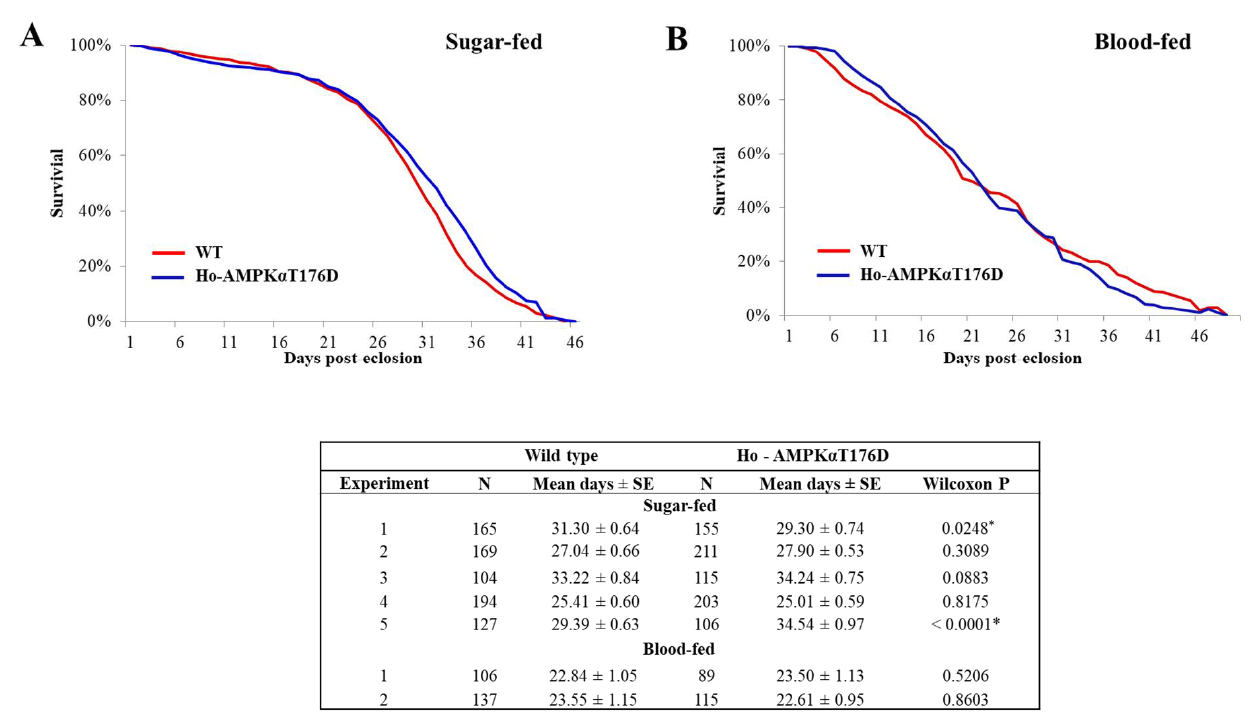
Figure 5. Survivorship of sugar-fed and blood-fed AMPK α T176D homozygous transgenic (TG) and wild type An. stephensi . ( A ) A representative survivorship curve comparing homozygous AMPK α T176D TG and wild type siblings reared under identical conditions and provided with 10% sucrose ad libitum . Lifespan experiments were replicated five times with independent cohorts of mosquitoes. ( B ) A representative survivorship curve comparing homozygous AMPK α T176D TG and wild type siblings reared under identical conditions and provided with a daily bloodmeal and 10% sucrose solution. Lifespan experiments were replicated twice with independent cohorts of mosquitoes. The table summarizes the sample sizes, means, and statistical analyses results (* p < 0.05) of lifespan data using the Wilcoxon test for sugar-fed and blood-fed